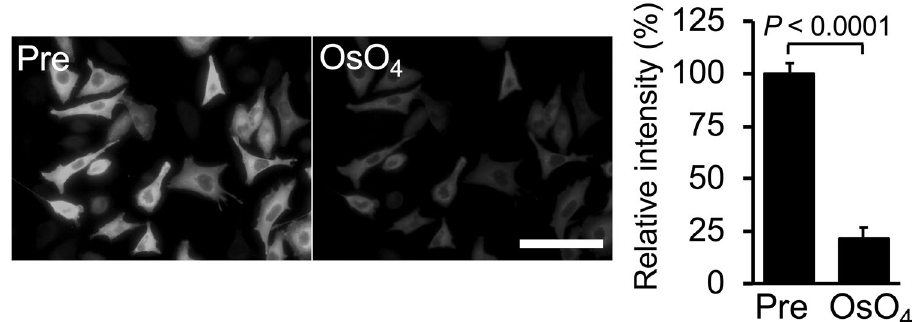
Figure 2. Fluorescent signals of biotinylated proteins were resistant to osmium tetroxide and Epon-embedding. ( A ) Changes of fluorescent signals following treatment with 2% osmium tetroxide at 4 °C for 30 min. Cells containing fluorophore-labeled biotinylated proteins were incubated in 2% osmium tetroxide at 4 °C for 30 min. Fluorescent images were obtained before ( Pre ) and after ( OsO 4 ) treatment with osmium tetroxide. The fluorescent intensity in ( A ) was evaluated by ImageJ software. Relative intensity is shown when the fluorescent intensity before the treatment as 100%. Scale bar, 100 μm. ** P value < 0.01, **** P value < 0.0001. Fluorescent images were obtained under the same conditions for mTurbo using a BZ-X810 fluorescence microscope (CCD monochrome camera, Nikon CFI Plan Apochromat × 40 lens, gain + 16 dB, on-chip binning off, exposure